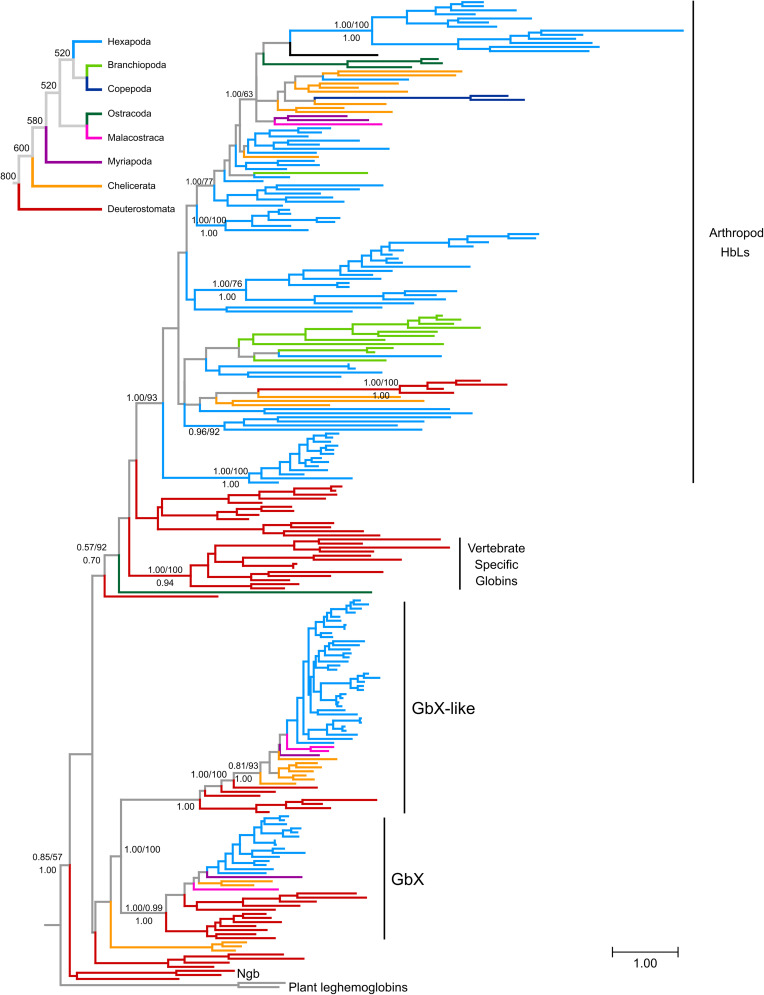
Maximum likelihood phylogram depicting relationships among globin genes from representative arthropods and deuterostome taxa. Numbers above the nodes correspond to support from the aBayes test and 1,000 pseudoreplicates of the ultrafast bootstrap procedure, whereas numbers below the nodes correspond to Bayesian posterior probabilities from MrBayes. The tree was rooted using plant globins as outgroup sequences. The inset on top shows the organismal phylogeny for the representative arthropod lineages included in the analysis, following Misof et al. (2014), with divergence time estimates derived from the TimeTree server (Kumar et al., 2017). Terminal branches were colored following the organismal tree. The full version of this figure is available as Supplementary Data Sheet S1.